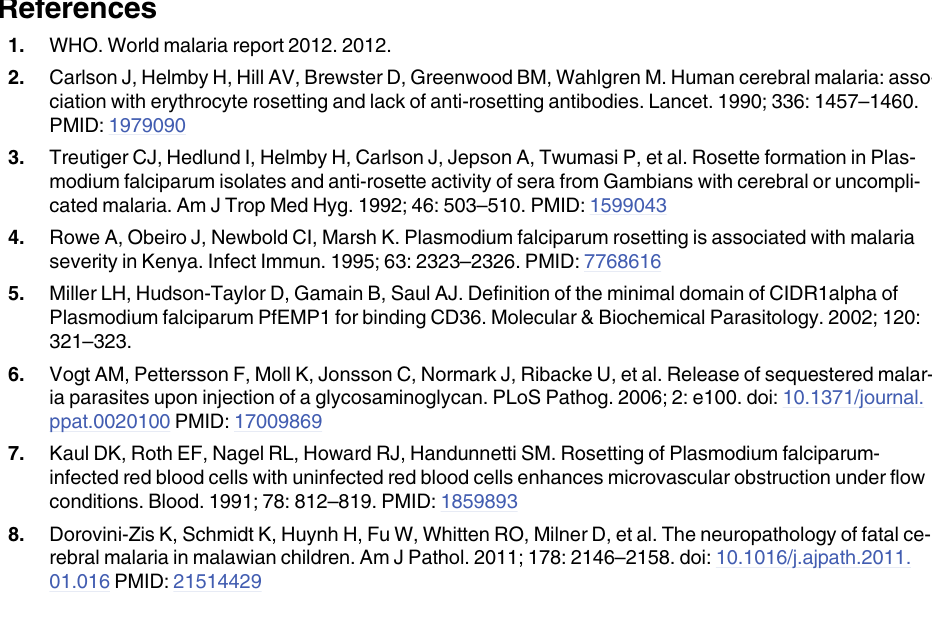
S2 Fig. Comparison of the heparin binding sites of NTS-DBL1 α PAvarO and SD1 of IT4var60. A) Comparison of the mutation in SD1 (K31 and K34, Mut H in cyan) of IT4var60 with the identified heparin binding site of PAvarO (K20, K32, K40, K423, K424, K451, K456). The mutated residues are not exactly in the corresponding position because the NTS-DBL1 α of IT4var60 lacks lysine residues in the corresponding position. B) Surface charge potential repre- sentation shows that PAvarO has a positively charged patch corresponding to the heparin binding site, which is lacking in the IT4var60 molecule. Blue: positive charge; white neutral charge; red: negative